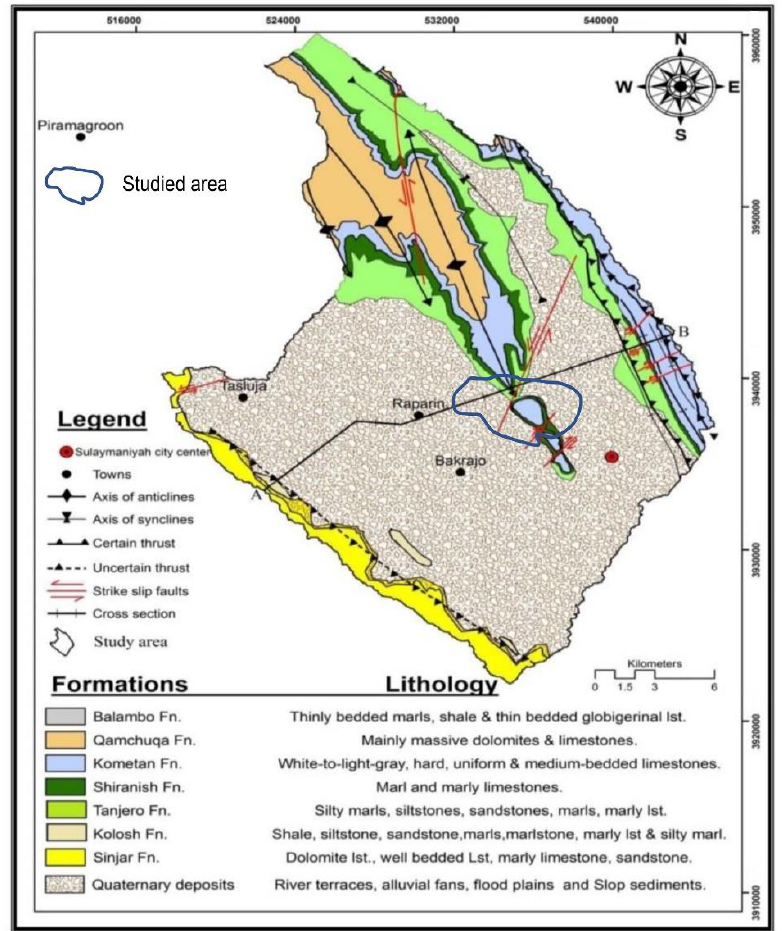
Figure 3. Geological map of the study area (based on [22]).